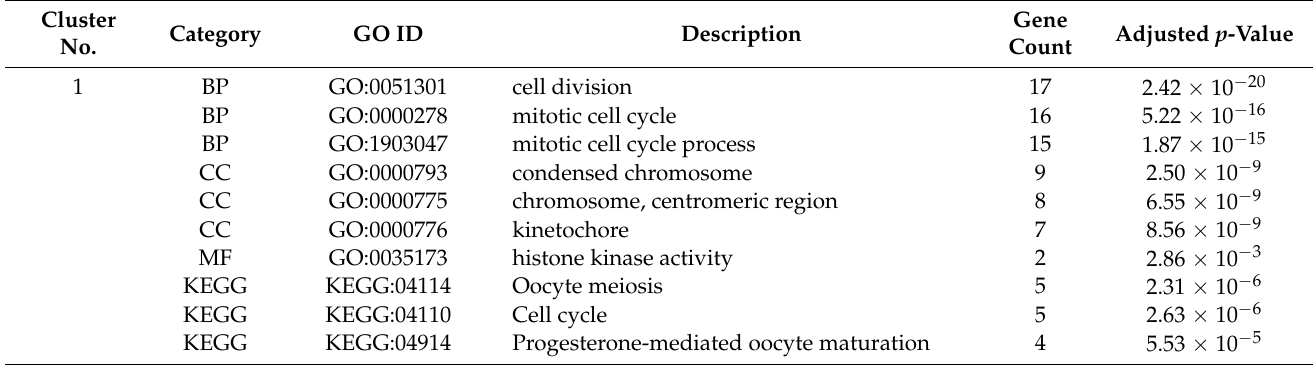
Figure 6. PPI network of all DEGs. The colour scale and node size indicate the connection degree. Purple and larger size represent higher degree, and vice versa. Red circles highlight the top 10 hub genes calculated by the plug-in MCODE on the Cytoscape. Table 4. Top three enriched BP, CC, MF, and KEGG terms in the sub-cluster 1, 2, and